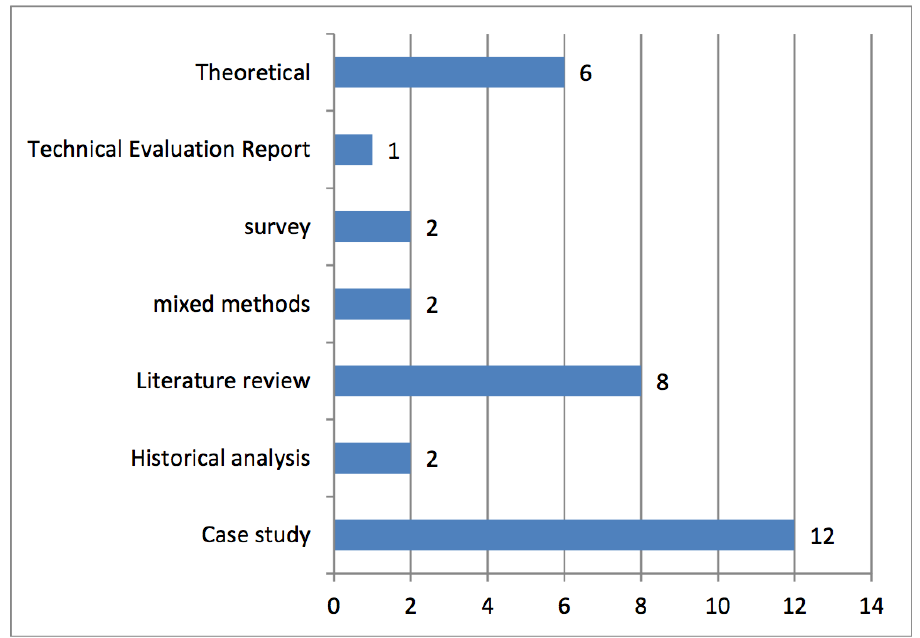
Figure 4. Frequencies of research types in highly cited articles .